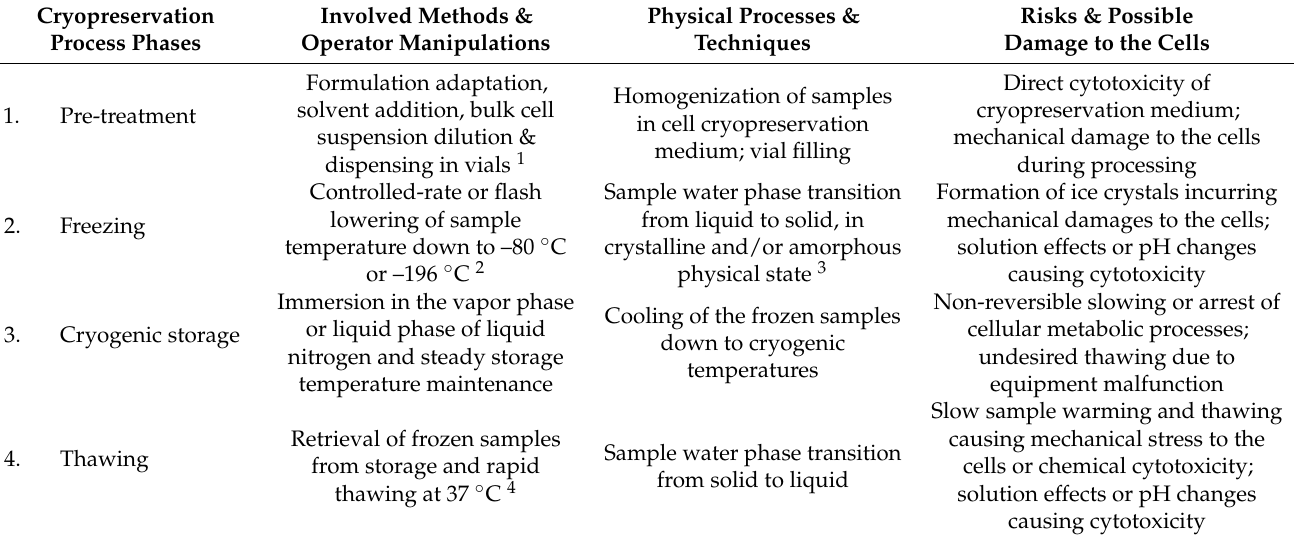
Table 1. Process phases, involved methods, and physical processes/techniques of cell cryopreserva- tion from pre-treatment to post-storage sample thawing. The involved risks and possible damage to the cells are presented for each step. This standard approach is used in the classical cytotherapeutic workflows investigated under the Swiss progenitor cell transplantation program (Figure 1) [15]. An illustrated workflow describing the various cryopreservation steps is presented in Figure